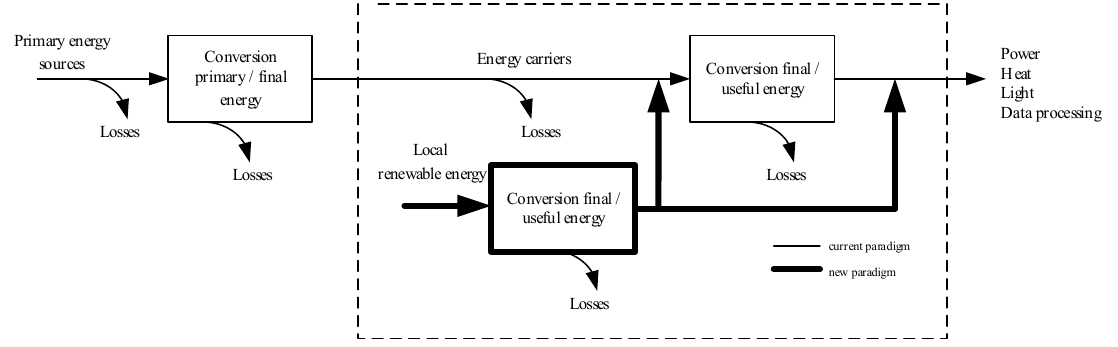
Figure 9. The current and suggested energy models (courtesy: WIT Press).